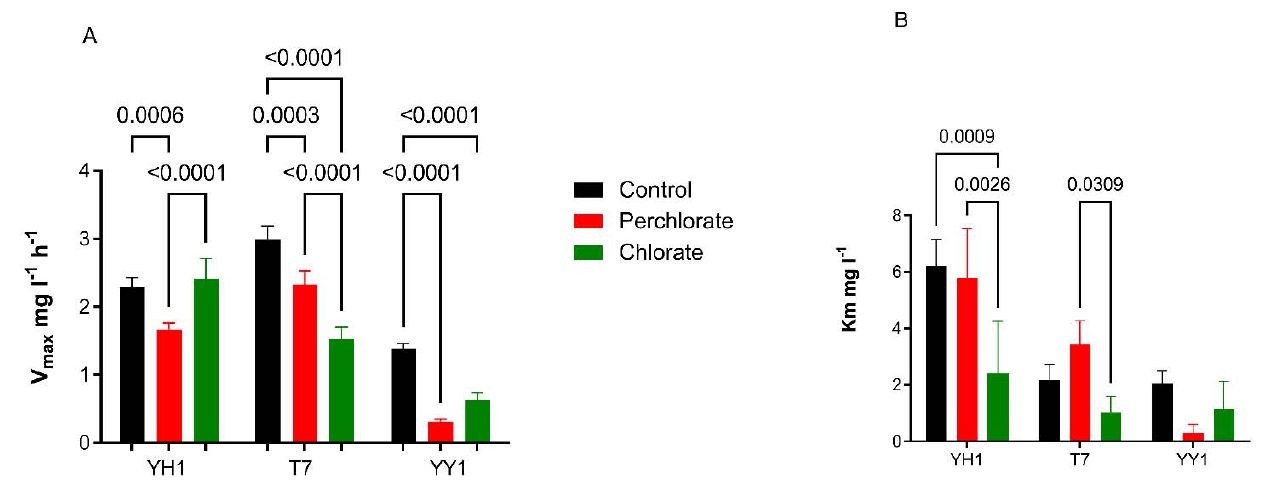
Figure 5. Effects of co-contaminants perchlorate and chlorate on RDX degradation of a resting cell suspension. Only significant p -values are presented. ( A ) Vmax, and ( B ) Km. The results are average ± standard deviation of triplicate cell suspensions for each RDX concentration.